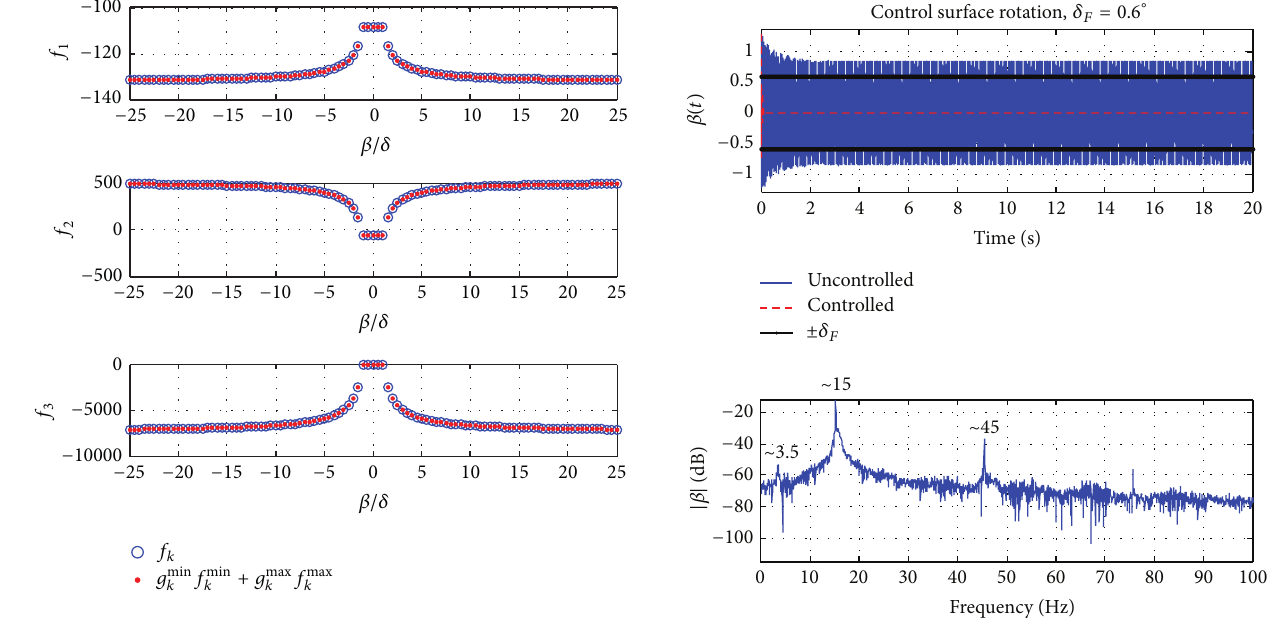
Figure 10: Values of 𝑓 𝑘 : actual versus computed using TS approach.